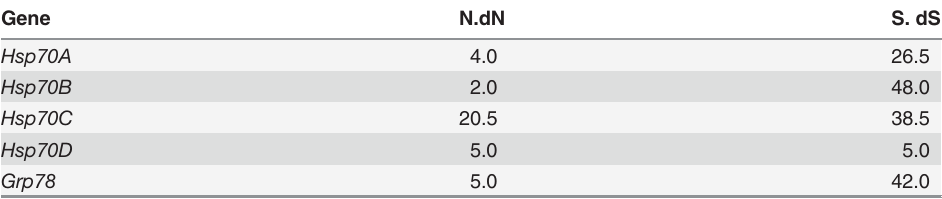
N.dN and S.dS estimates obtained between E . superba and E . crystallorophias for the 5 paralogous Hsp70 genes using the Nei-Gojobori method [79] to make evolutionary-rate comparisons under the assumption of a global molecular